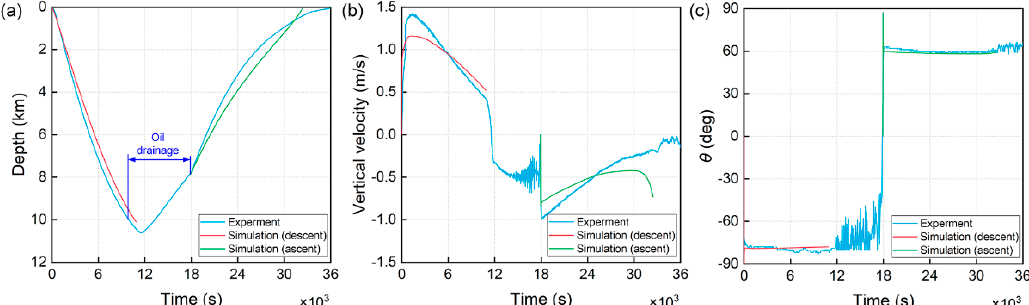
Figure 21. Experimental results and simulation comparison of the VM mode: ( a ) Depth vs. time; ( b ) Vertical velocity vs. time; ( c ) θ vs. time.